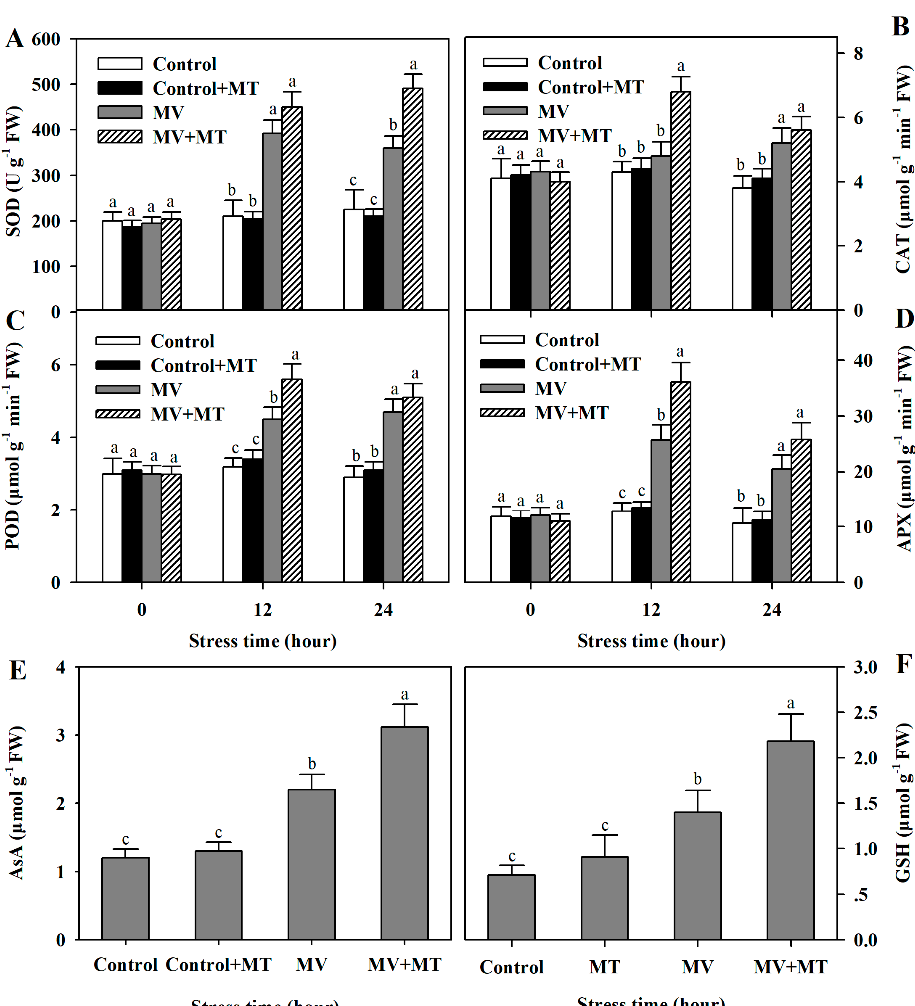
Figure 4. Changes in activities of antioxidant enzymes and levels of non-enzymatic antioxidants as affected by melatonin in poplar leaf discs under MV stress. ( A ) superoxide dismutase (SOD); ( B ) catalase (CAT); ( C ) peroxidase (POD); ( D ) ascorbate peroxidase (APX); ( E ) AsA. ( F ) GSH. Poplar leaf discs were pretreated with 150 µ M melatonin in the dark for 12 h, and then, leaf discs were exposed to 50 µ M methyl viologen in the light for 24 h. Leaf discs were collected at 0, 12 and 24 h following MV treatment. The values presented are means ± SDs ( n = 3). Different letters indicate significant difference at p < 0.05 among treatments.